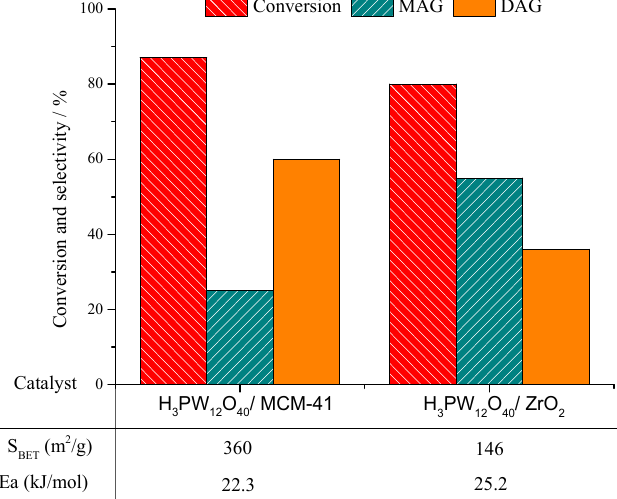
Figure 12. Conversion and selectivity of H 3 PW 12 O 40 /MCM − 41 or H 3 PW 12 O 40 /ZrO 2 − catalyzed reactions of glycerol esterification with HOAc (adapted from ref. [53]). Reaction conditions: glycerol: HOAc molar ratio (1:6); catalyst mass (150 mg); H 3 PW 12 O 40 load (30 wt.%); time (6 h); temperature (373 K).